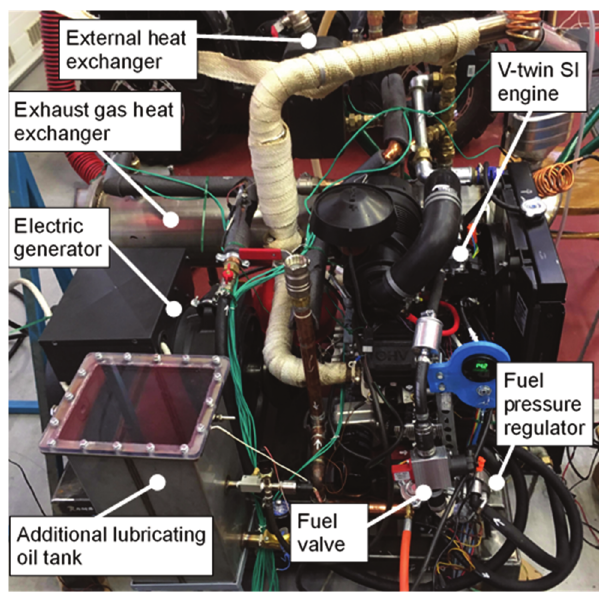
Fig. 1. The prototype cogeneration